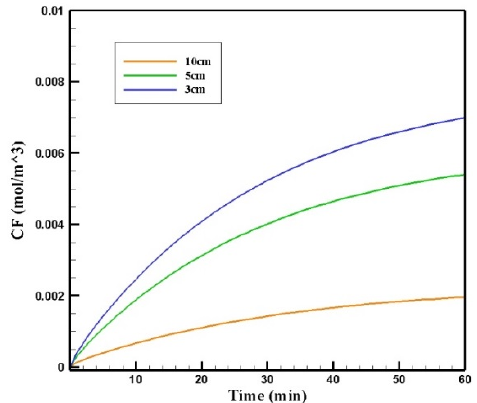
19 of 24 Figure 19. Contours of the magnetic field ( H ) around the permanent magnet and in the solution area. Figure 20 shows the contours of C F in the tumor for three different distances of the permanent magnet from the tumor including 3, 5, and 10 cm. The comparison of the con- tours shows that by increasing the distance, a smaller part of the tumor was affected by the drug. This reduction in penetration occurred dramatically, especially by increasing the distance of the magnet from the tumor to 10 cm. According to Figure 21, C F values 60 min after the injection at a distance of 3 cm was 0.0069 mol/m 3 , while increasing the distance to 10 cm decreased the C F value to 0.0019 mol/m 3 . 3 cm